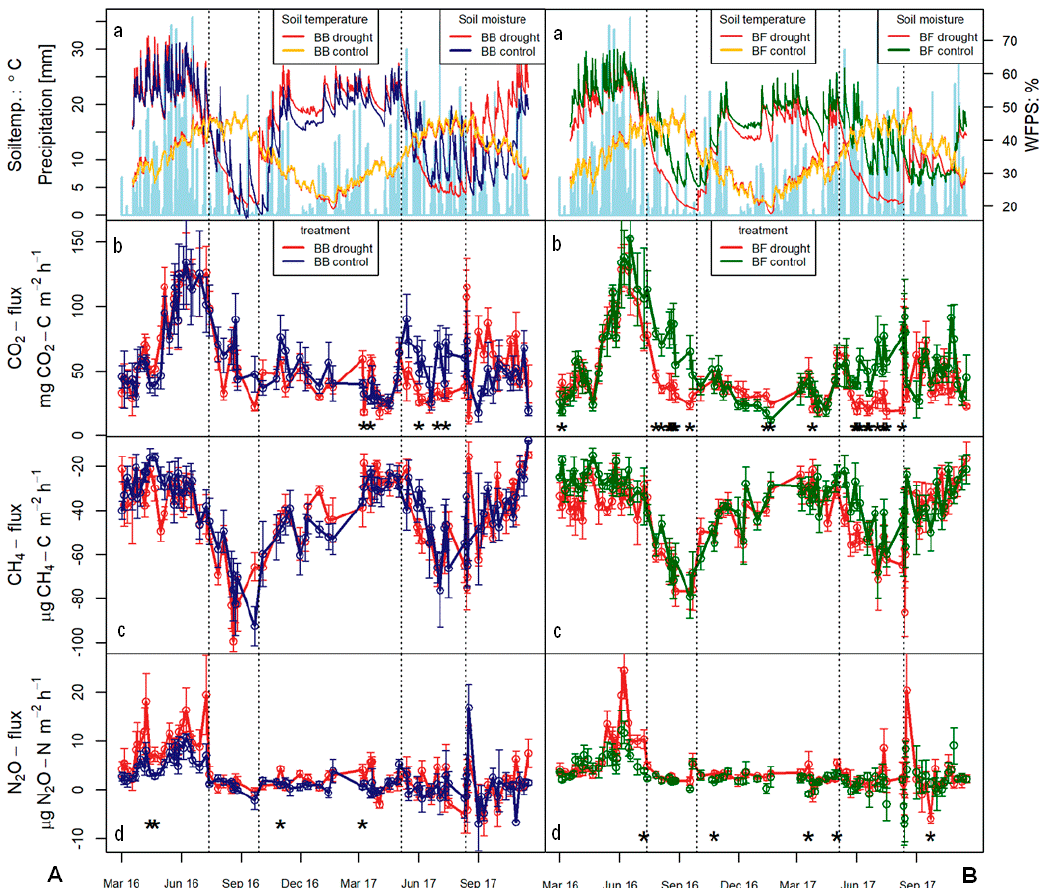
Figure 2. Soil temperature and soil moisture ( a ) and the soil-atmosphere exchange of CO 2 ( b ), CH 4 ( c ) and N 2 O ( d ) as influenced by rainout shelters in summer for pure beech stands ( A ) and mixed beech-fir stands ( B ): The dotted lines indicate the start and end of the simulated drought period in summer (BF/BB drought). The uncertainty is given as the standard error of the mean ( n = 5–6). WFPS: Water filled pore space. The asterisks indicate significant differences between the BB/BF control and the BB/BF drought at the given sampling dates (Wilcoxon–Mann–Whitney test, p < 0.05).